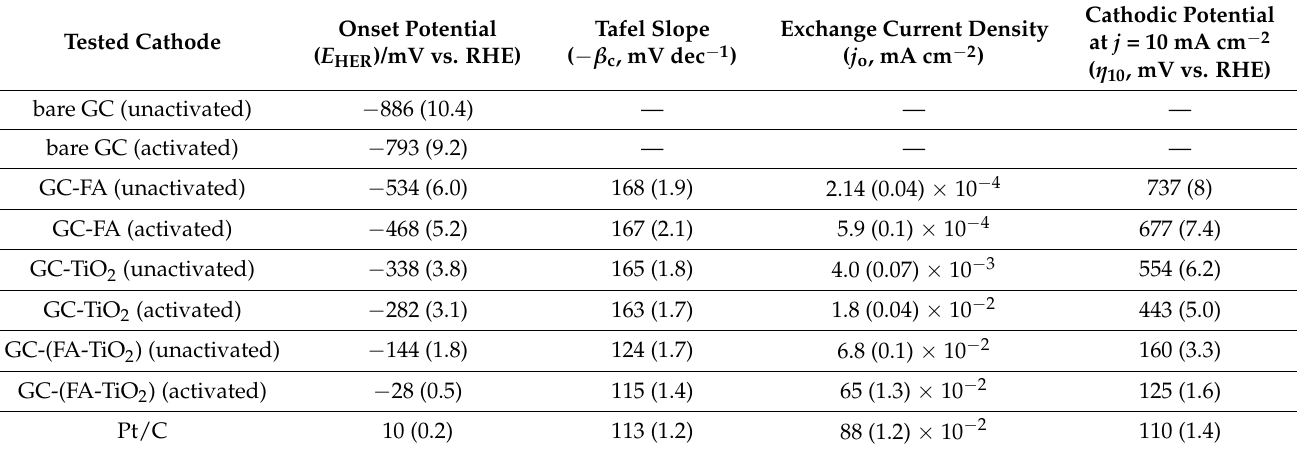
Table 2. Mean value (standard deviation) of the electrochemical HER kinetic parameters on the tested electrocatalysts (unactivated and cathodically activated). Measurements were conducted at room temperature in deaerated 0.1 M KOH